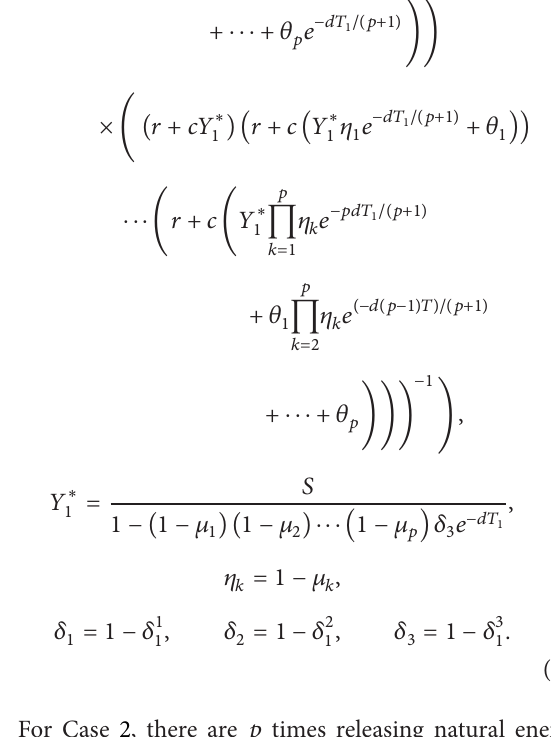
= 0.58 , 𝛿 = 0.62 , 𝛿 = 1 2 3